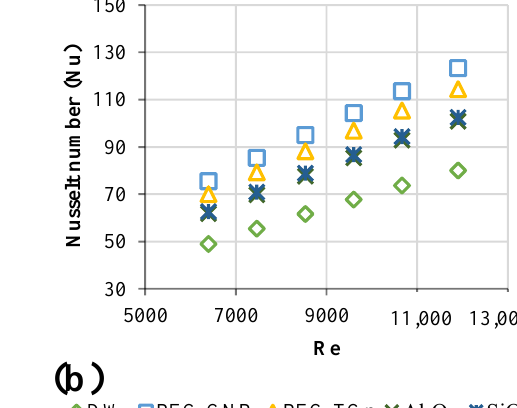
Figure 6. The verification assessment; ( a ) heat transfer coefficients measurement and prediction for 11,205 W/m 2 , ( b ) the magnitude of the relative error metric, ( c ) The value of the average Nusselt number at 11,205 W/m 2 , ( d ) the magnitude of the relative error metric, ( e ) Frictional head loss, ( f ) the magnitude of the relative error metric, ( g ) Pressure loss, ( h ) the magnitude of the relative error metric.